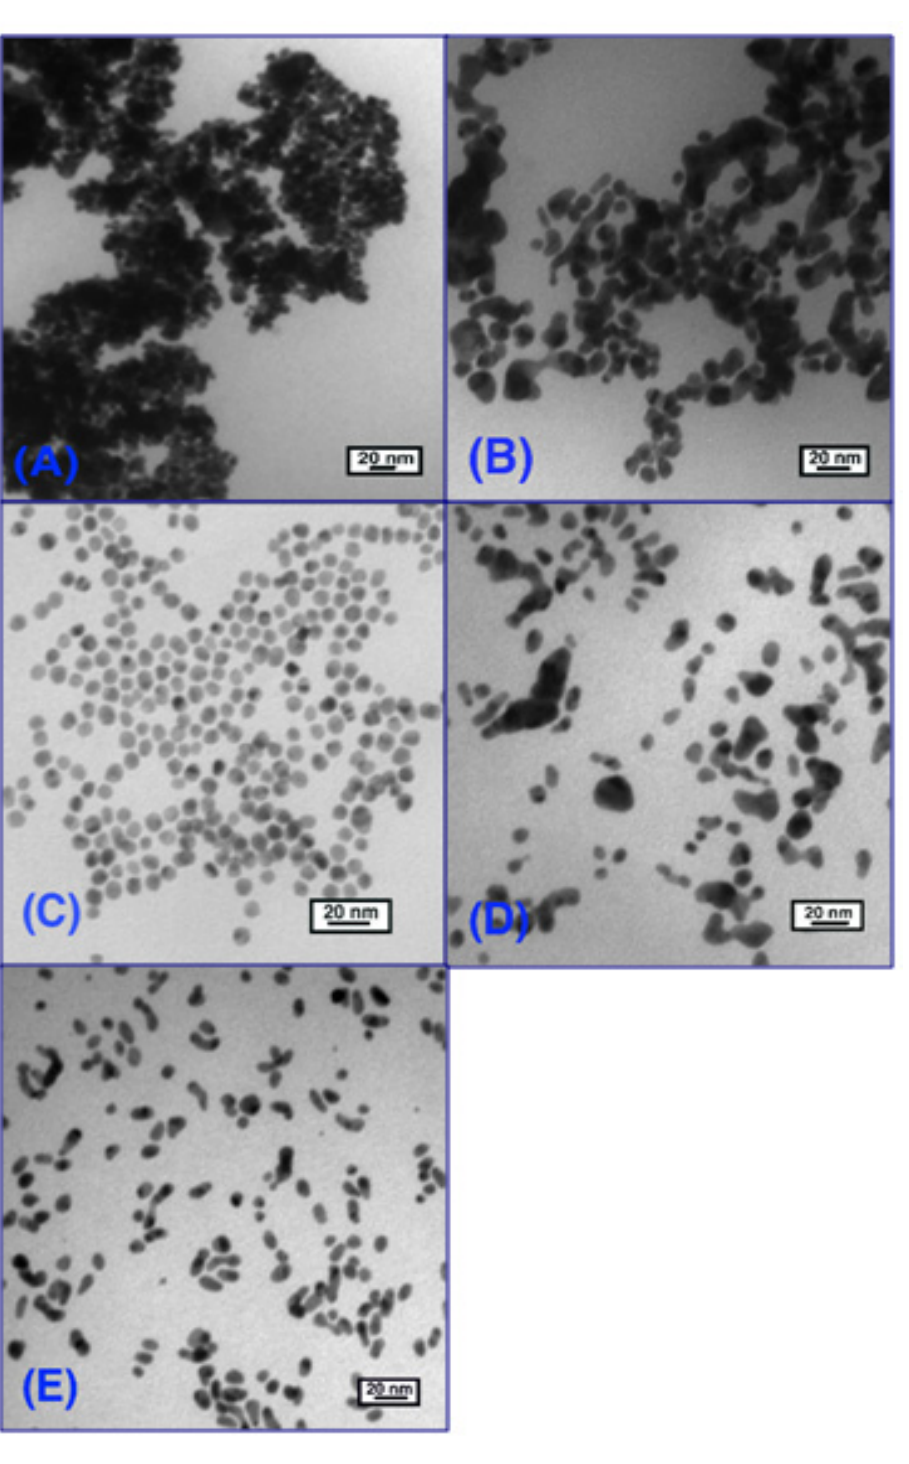
N colloids after digestive ripening in ( E ) Au-C 18